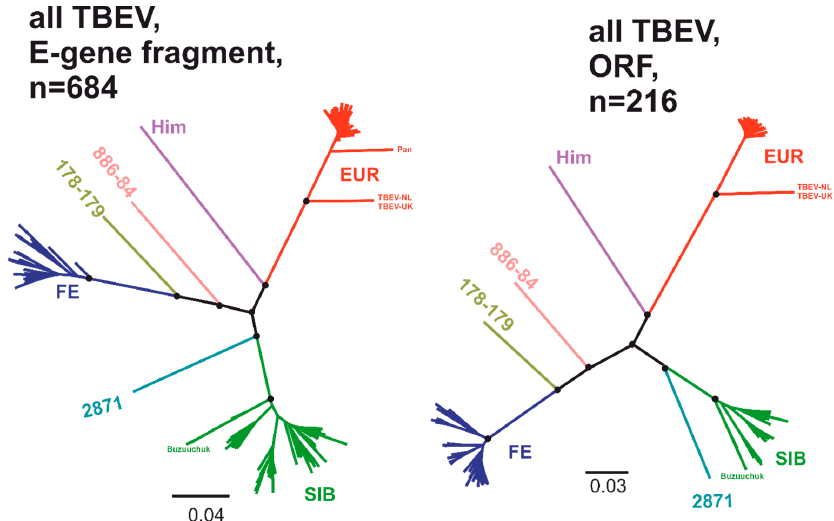
Figure 1. Unrooted maximum likelihood tree for Tick-borne encephalitis virus ( TBEV ; E gene fragment—left panel, complete open reading frame (ORF)—right panel). Black circles indicate high-level nodes that were supported by UFBoot values over 95% [36]. The scale bar and branch lengths represent the expected number of substitutions per site.